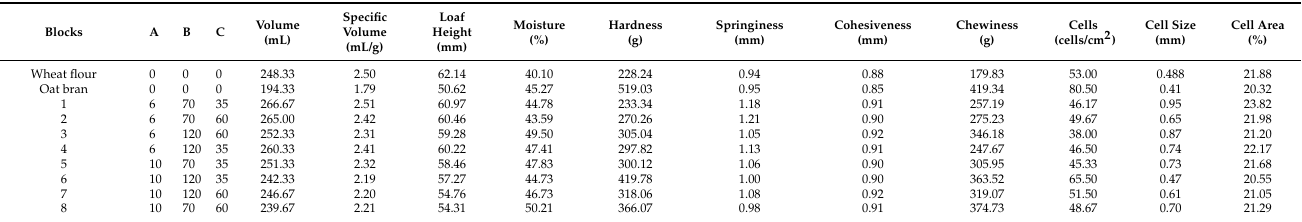
Table 1. Effect of enzymes combination on the physical properties of CSB.